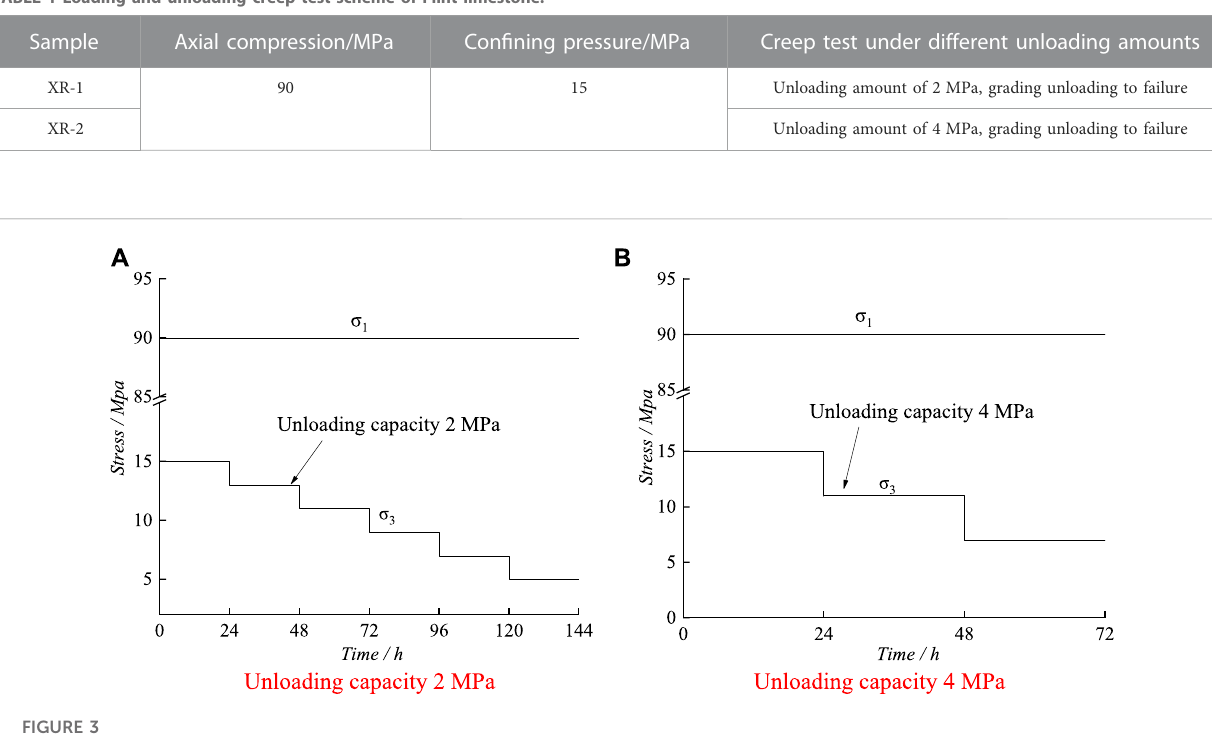
TABLE 1 Loading and unloading creep test scheme of Flint limestone.